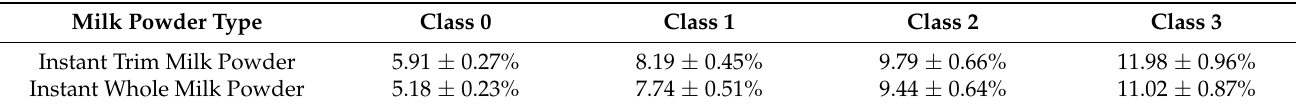
Table 1. The actual moisture